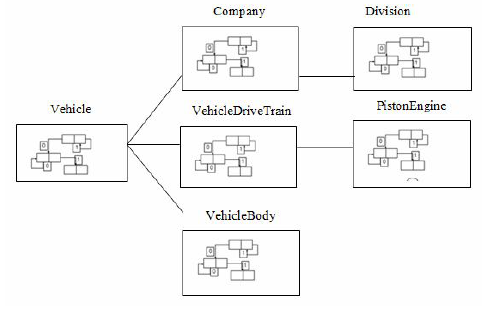
Algorithm 5. Parent node